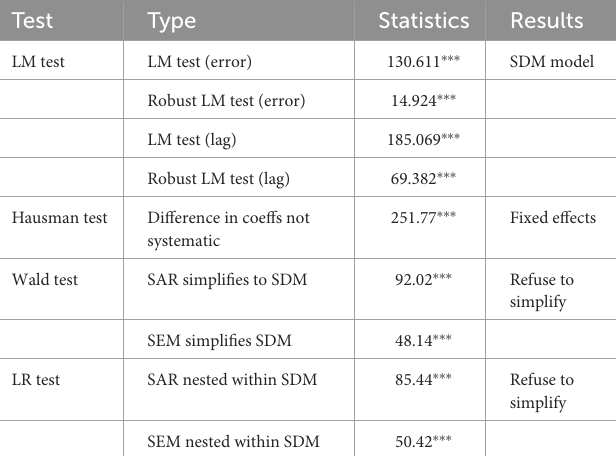
TABLE 4 Spatial model correlation test results. TABLE 5 Estimation